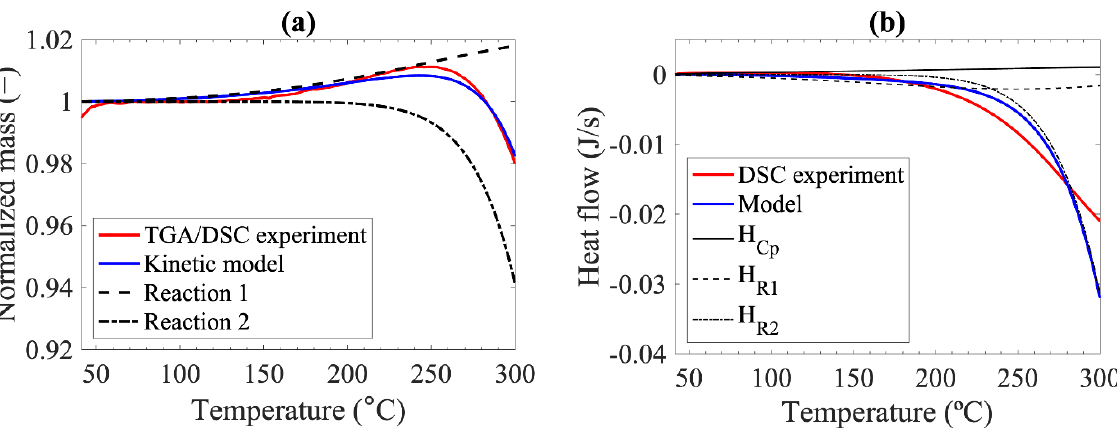
Figure 3. TGA-DSC result in comparison with the models for: ( a ) mass; and ( b ) heat.